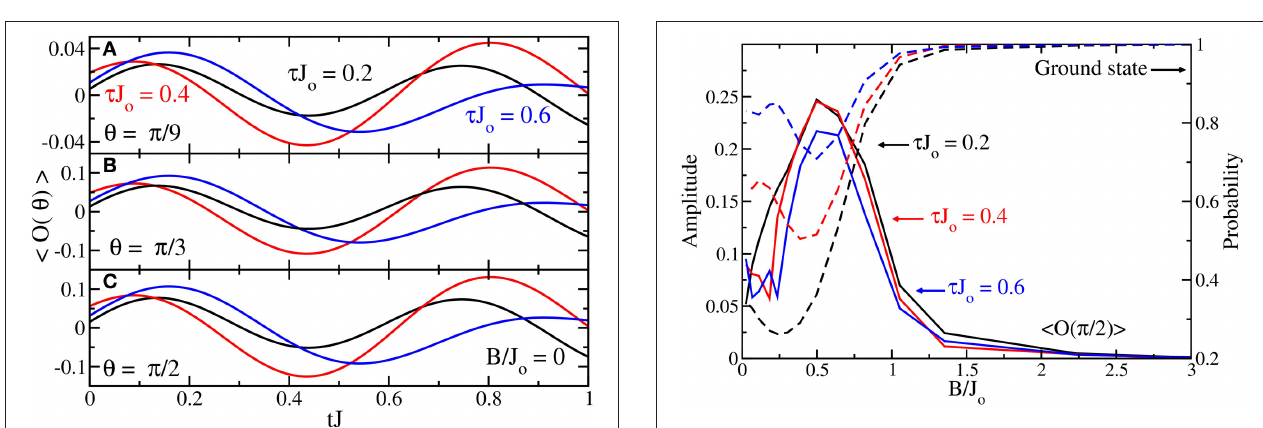
FIGURE 10 | Amplitude of the oscillations when the transverse-field Ising model is held at different B / J o for 3 different τ = 0.2 (black), 0.4 (red), and 0.6 (blue), (where the arrows point toward the appropriate vertical axis; solid lines are the amplitude of oscillations, axis on the left and dashed lines are the ground-state probability, axis on the right). Before the minimum energy gap, the oscillations increase as the probability of the ground state decreases. However, after the minimum energy gap is passed, depletion of the excited states back to the ground state occurs and the amplitude of the oscillations decrease accordingly. This depletion is difficult to detect by measuring the amplitude of the oscillations at only one